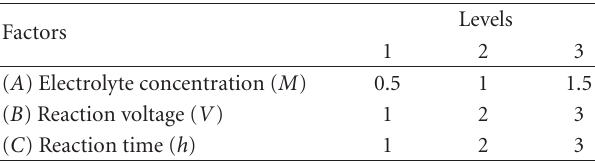
Table 1: Factors and levels for orthogonal experiments. Factors